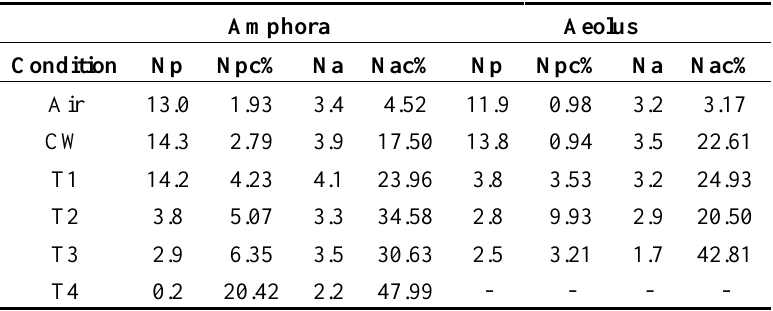
Table 3. Acquired 3D points per 100 pixel (Np for passive and Na for active stereo) and percentage values of deleted 3D points (Npc% for passive Nac% for active stereo) for Amphora and Aeolus. Amphora